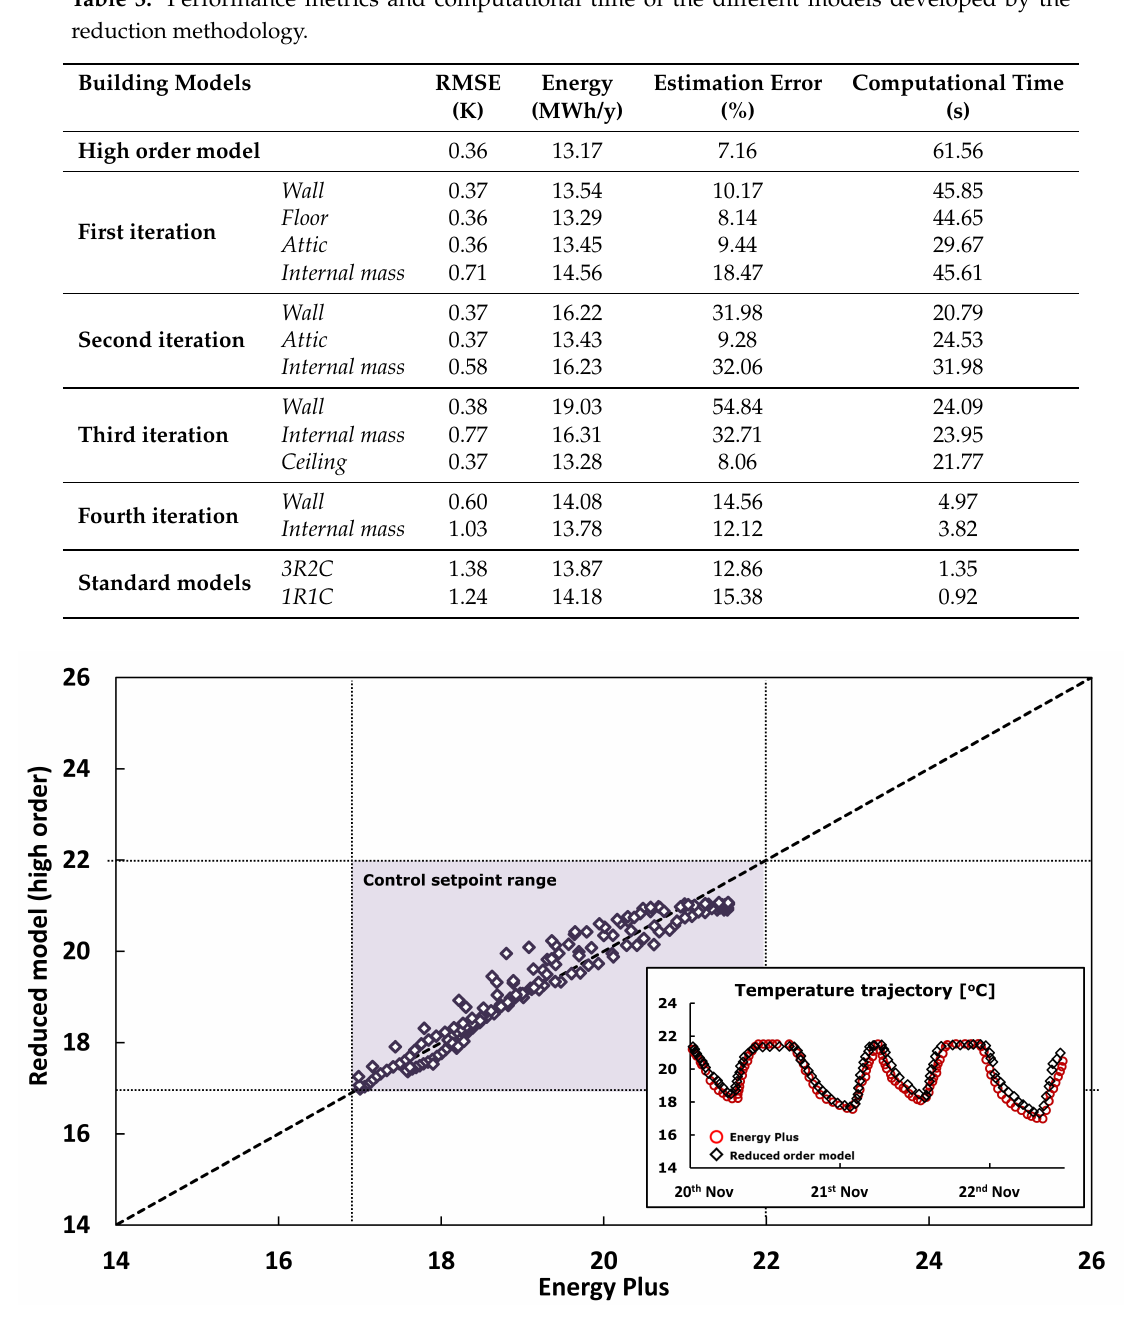
Figure 11. Temperature trajectories computed by Energy Plus and the high order reduced model during three consecutive days in